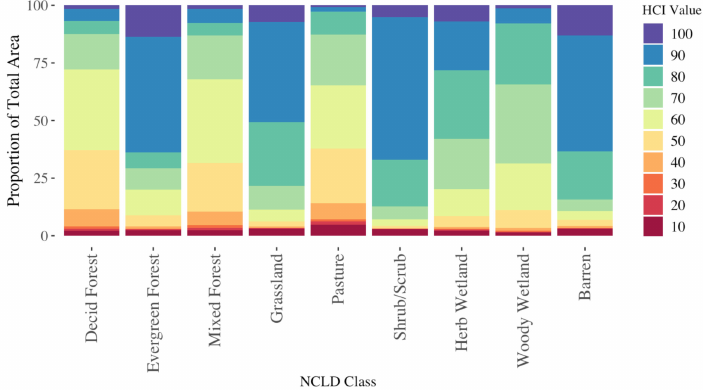
Figure 6. Habitat Condition Index (HCI) values by land cover class across the CONUS. Hypothesis